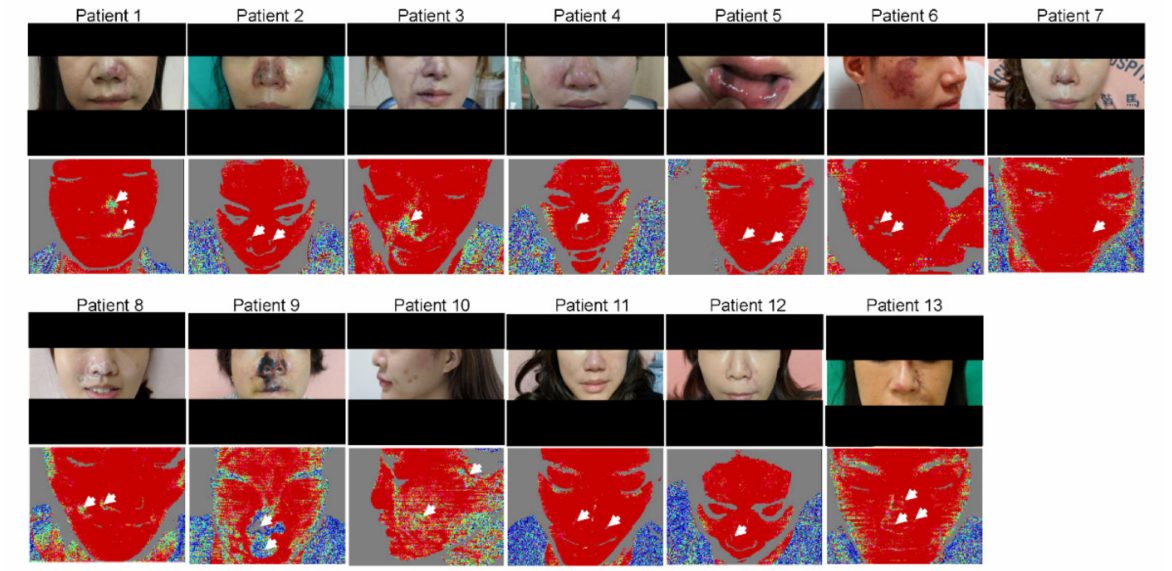
Figure 1. Clinical photographs and laser Doppler imaging of all patients. At Day 1 of admission, the clinical photographs and DPI represent arterial occlusions in the region of facial filler injection (closed arrows).